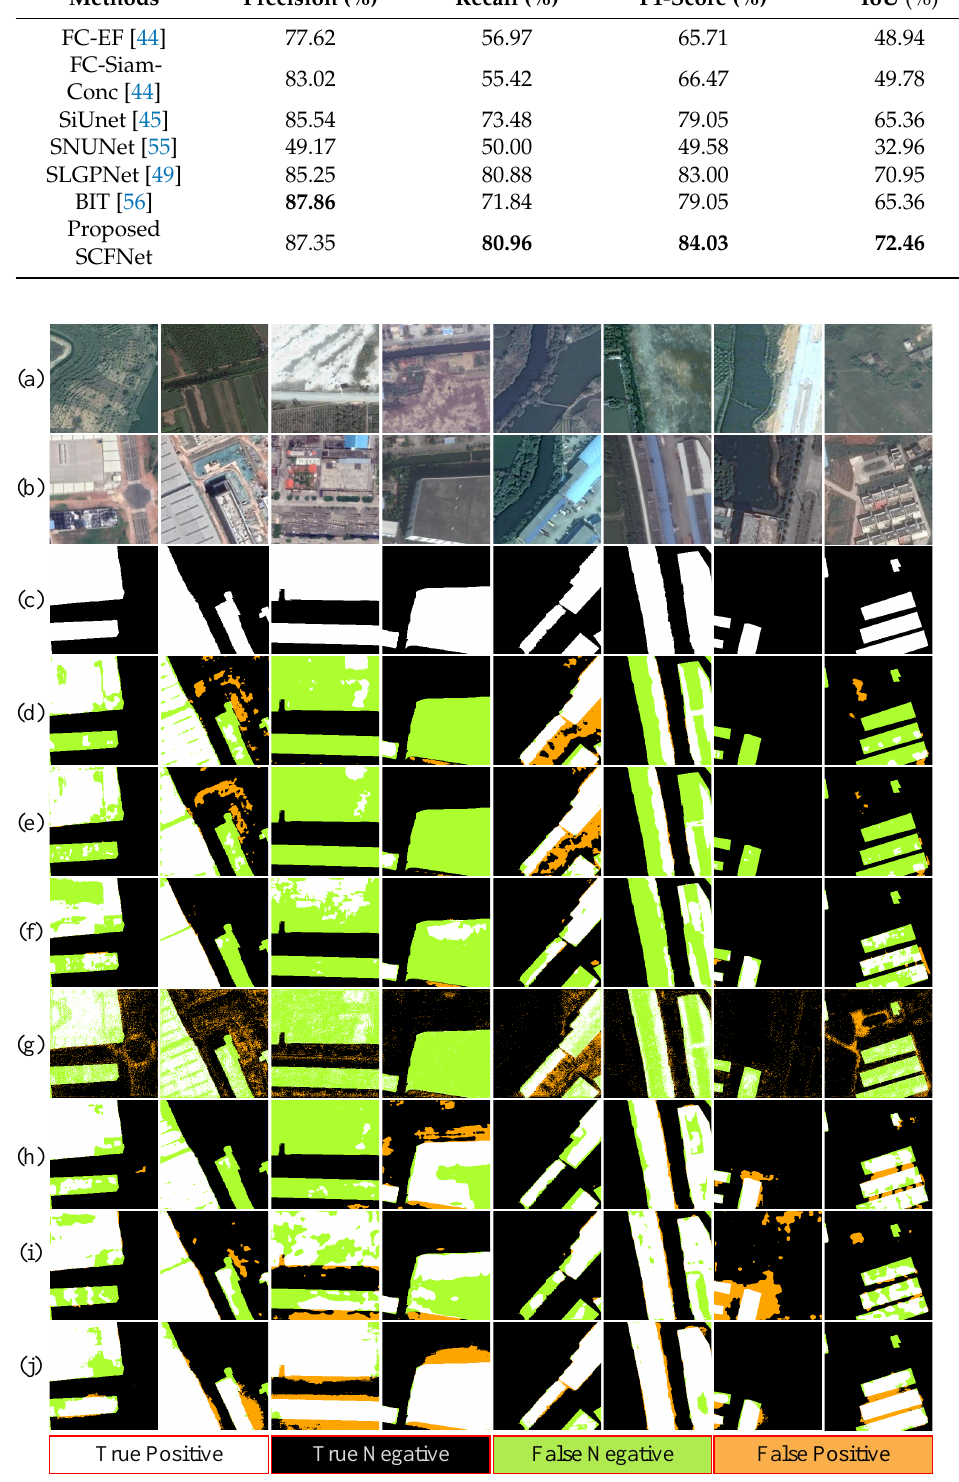
Figure 8. The results of different methods on Guangzhou data set: ( a ) T 1 -time image; ( b ) T 2 -time image; ( c ) ground truth image; ( d ) FC-EF [44]; ( e ) FC-Siam-Conc [44]; ( f ) SiUnet [45]; ( g ) SNUNet [55]; ( h ) SLGPNet [49]; ( i ) BIT [56]; and ( j ) proposed